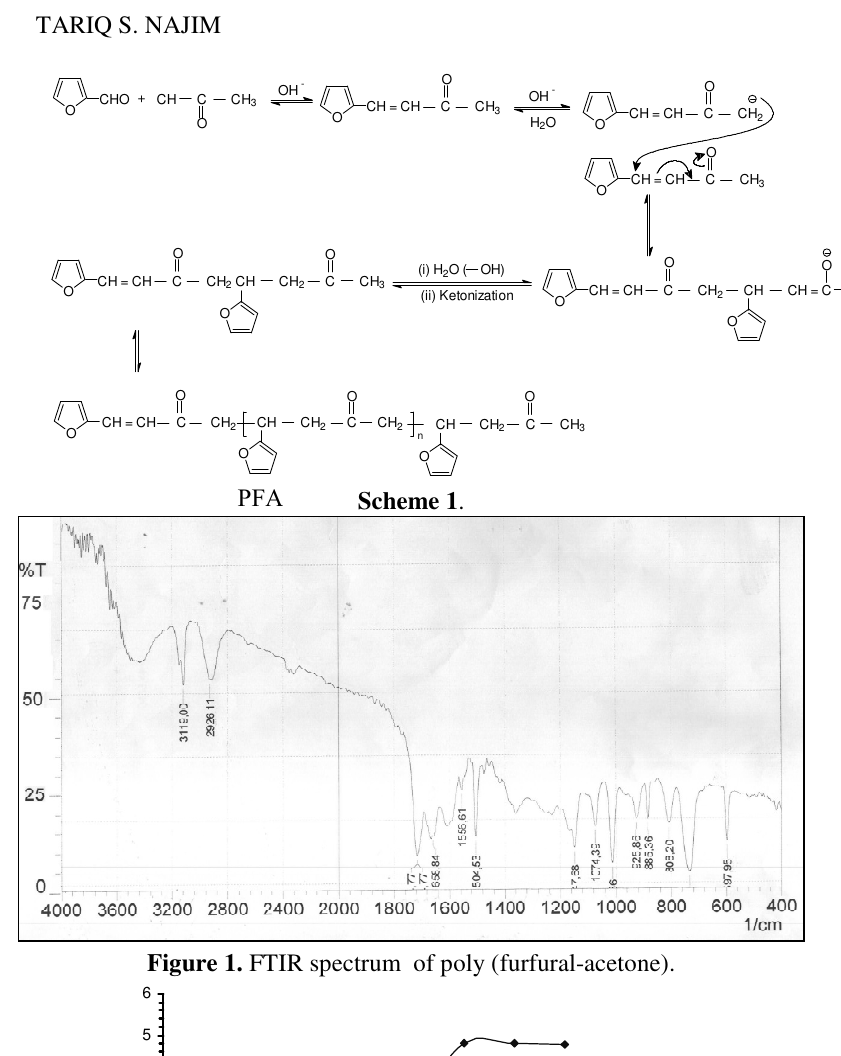
Figure 1. FTIR spectrum of poly (furfural-acetone).